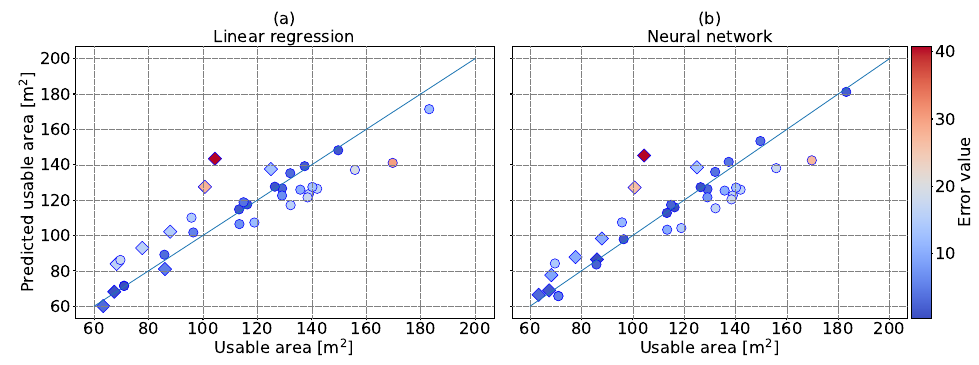
Figure 5. Predictions of ( a ) the linear regression and ( b ) the neural network with 10 hidden neurons of the usable area of buildings from architectural bureaus, with a distinction between one- (diamonds) and two-story (dots) buildings. Input features are the covered area and the building’s